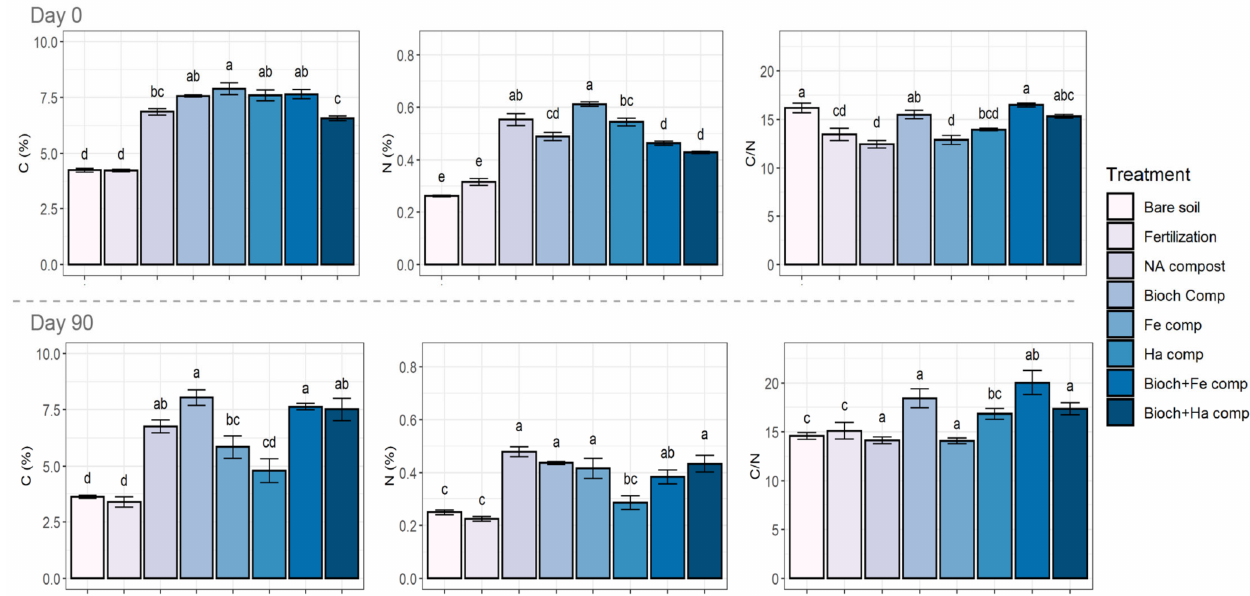
Figure 1. Carbon, nitrogen contents and C/N ratio of different treatments at the beginning and end of the greenhouse experiment (day 0 and 90). Lower-case letters indicate significantly different means at p <